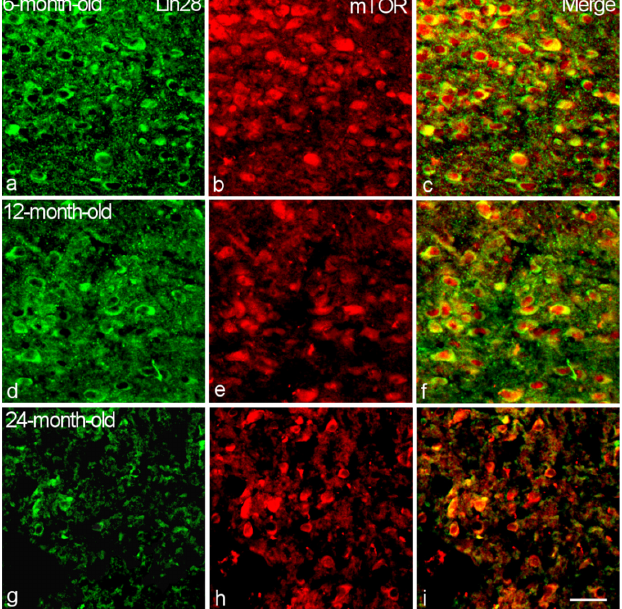
Figure 6. Colocalization of Lin28 with mTOR in the VMH neurons of 6-month-old ( a – c ), 12-month-old ( d – f ) and 24-month-old ( g – i ) male rats. Double labeling of Lin28 ( a , d , g , green, left panel), mTOR ( b , e , h , red, middle) and composite image ( c , f , i , right). Bar, 25 µm.